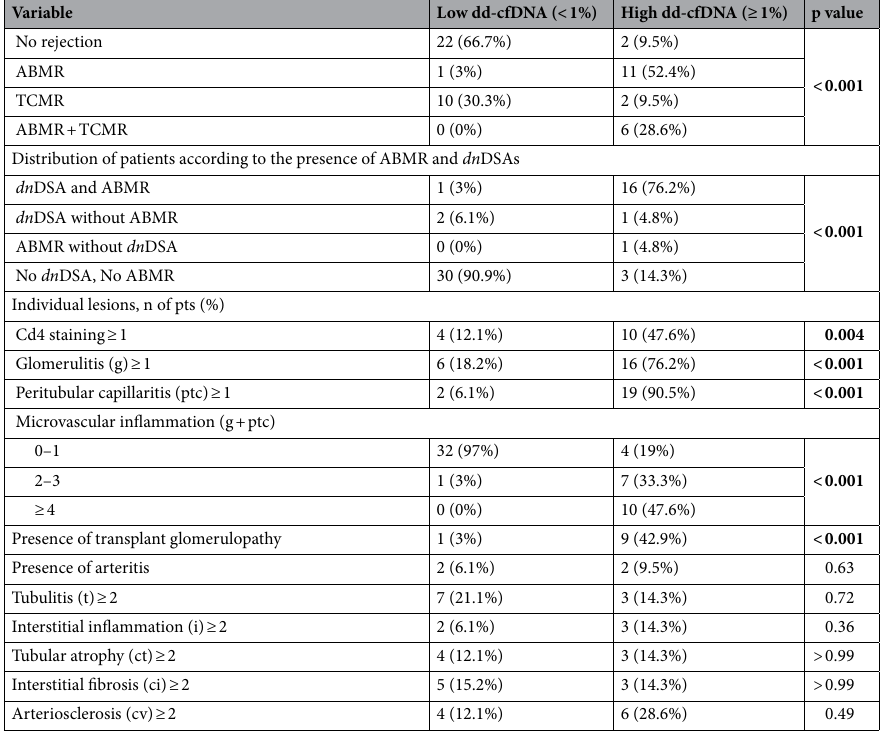
Table 3. Baseline patient characteristics according to the level of dd-cfDNA (biopsy cohort). dd-cfDNA, donor-derived cell-free DNA; dn DSA, de novo donor-specific antibody; MFI, mean fluorescence intensity; ABMR, antibody-mediated rejection; TCMR, T-cell mediated rejection; eGFR, estimated glomerular filtration rate; UPCR, urine protein:creatinine